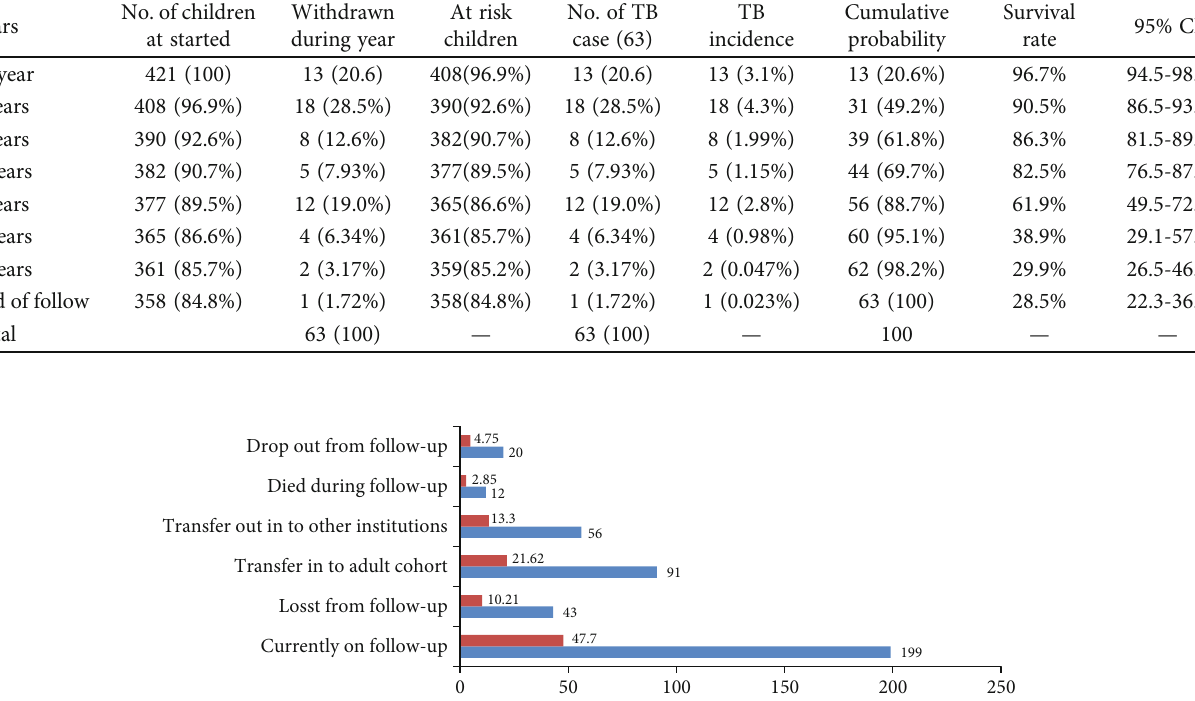
Figure 2: Seropositive children started HIV/AIDS care status in two public hospitals during data collection in public January 2011 to December 31/2020, North West Ethiopia ( N = 421